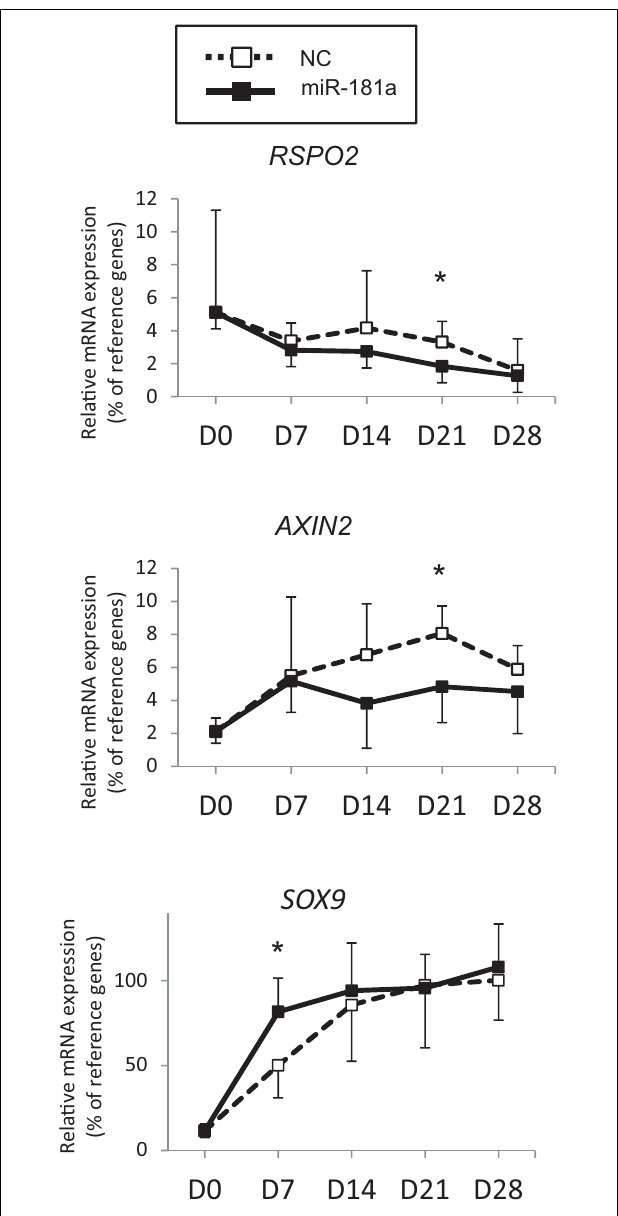
FIGURE 3 | MSC ( N = 5–6 donors) were transfected with miR-181a (black line, black squares), or with a control non-targeting miR (NC, black dotted line, white squares) mimic at day 0, then subjected to chondrogenic differentiation for 28 days, and mRNA expression for indicated genes was monitored at indicated time points by qRT-PCR. Levels of mRNA expression were normalized to a geomean of HPRT, CPSF6 and RPL13 . Error bars correspond to mean values ± SD; * p ≤ 0.05, NC vs miR-181a at indicated time points (Mann–Whitney U